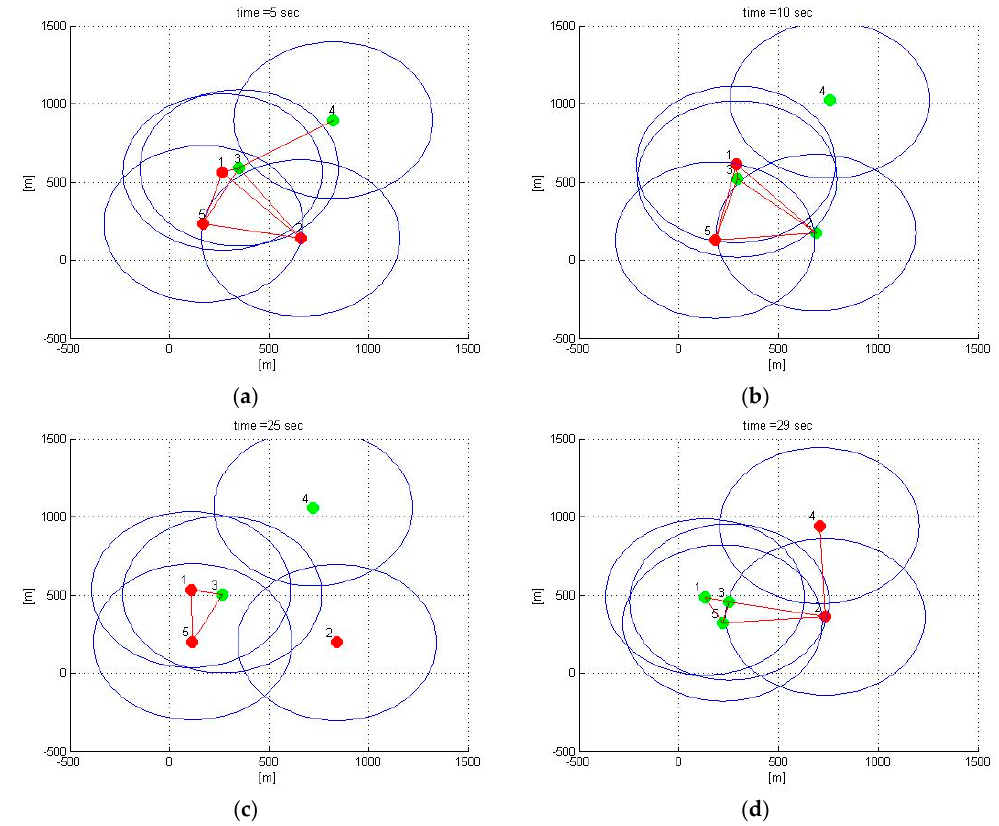
Figure 4. Fleet true position ( a ) t = 5 s ( b ) t = 10 s ( c ) t = 25 s ( d ) t = 30 s.